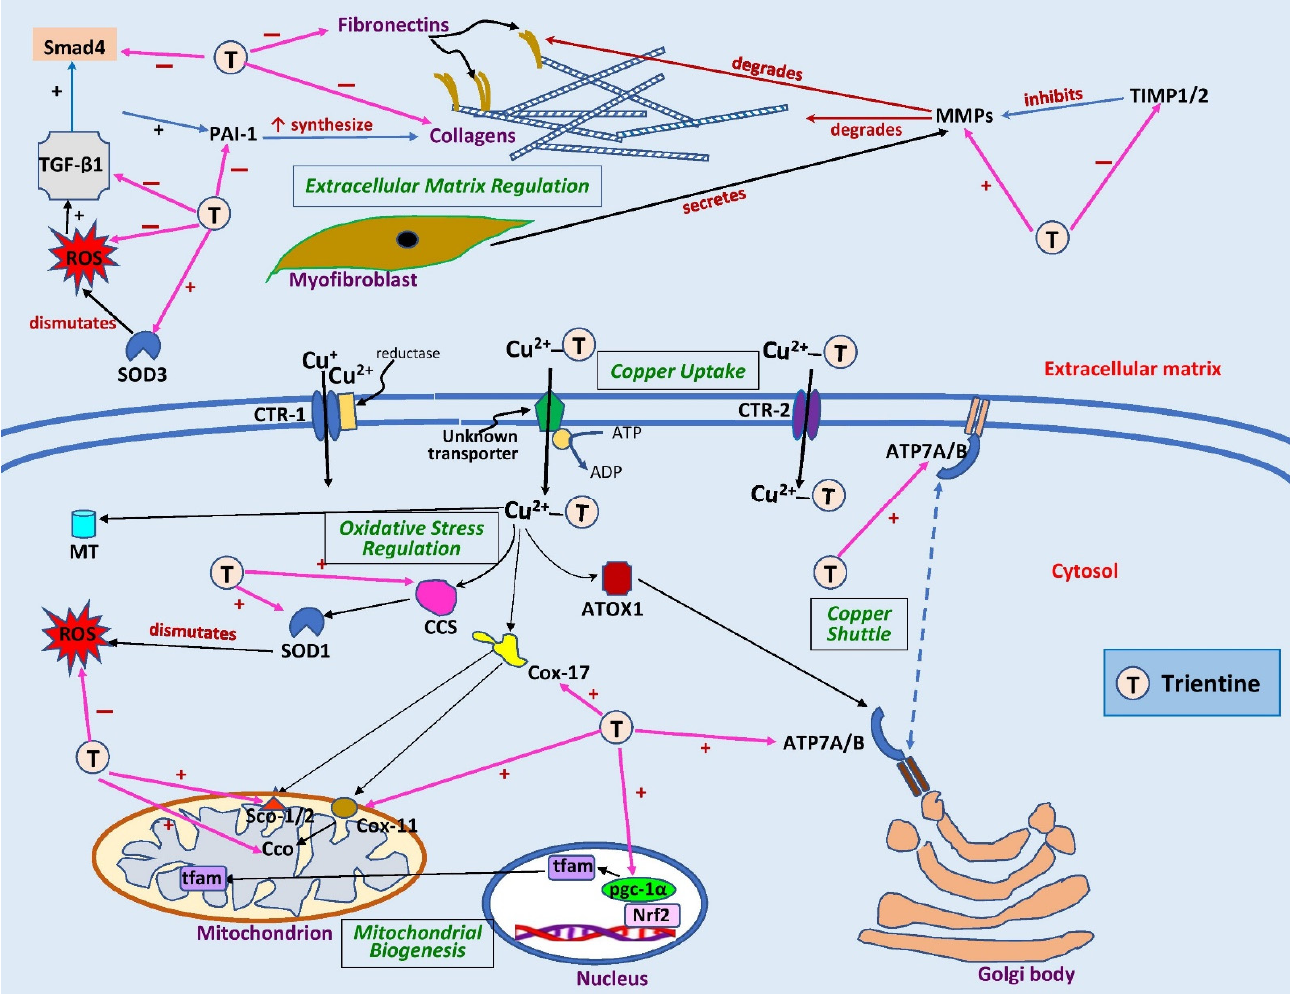
Figure 2. Sites of action of trientine in cardiac remodeling. Extracellularly, trientine reduces interstitial fibrosis by inhibiting tissue inhibitor of metalloproteinase 1/2 (TIMP1/2), leading to an increase in matrix metalloproteinases (MMPs). This, in turn, augments collagen degradation. Inhibitory effects of trientine on transforming growth factor- β 1 (TGF- β 1), plasminogen activator inhibitor-1 (PAI-1), and small mothers against decapentaplegic (Smad4) lead to decreases in expression of matrix proteins (collagen and fibronectin). The complex of trientine-Cu(II) is brought into cells by an unknown transporter and partly by copper transporter-2 (CTR-2). The drug increases the expression of superoxide dismutase-1 (SOD1) and -3 (SOD3) as well as copper chaperone for superoxide dismutase-1 (CCS), leading to a decrease in reactive oxygen species (ROS) formation. Trientine also elevates the expression of cytosolic soluble cytochrome c oxidase (Cco) copper chaperones 11 (Cox11) and 17 (Cox17), cytochrome c oxidase assembly protein-1/2 (Sco1/2), and peroxisome proliferator-activated receptor coactivator-1 α (pgc-1 α ), which improves mitochondrial biogenesis and function. It also augments the expression of ATPase copper-transporting α (ATP7A) but has no effect on ATPase copper-transporting β (ATP7B) or antioxidant 1 copper chaperone (ATOX1), which are responsible for shuttling copper into trans-Golgi network or secretory vesicles. CTR-1, copper transporter 1; MT, metallothionein; nrf2, nuclear factor erythroid 2-related factor 2; tfam, mitochondrial transcription factor A; ↑ , significant increase; +, stimulates; − , inhibits. Blank arrows demonstrate subsequent events; brown arrow indicates degradation, dashed blue arrow displays translocation of copper, and pink arrows indicate the sites of action of trientine.